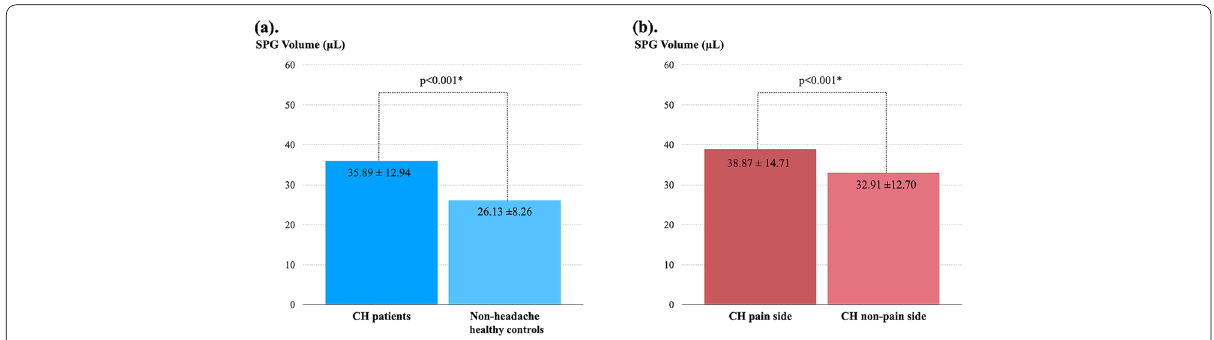
a Differences in volume and diameters between CH and non-headache healthy controls were analyzed by independent samples t-test b Differences in volume and diameters between the pain side and non-pain side were analyzed by paired t-test # p < 0.05 was considered statistically significant